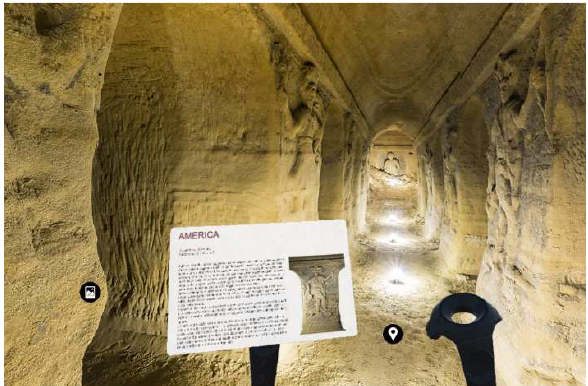
Figure 9: Immersive Virtual Reality, visualization of info about the selected bas-relief inside a spherical